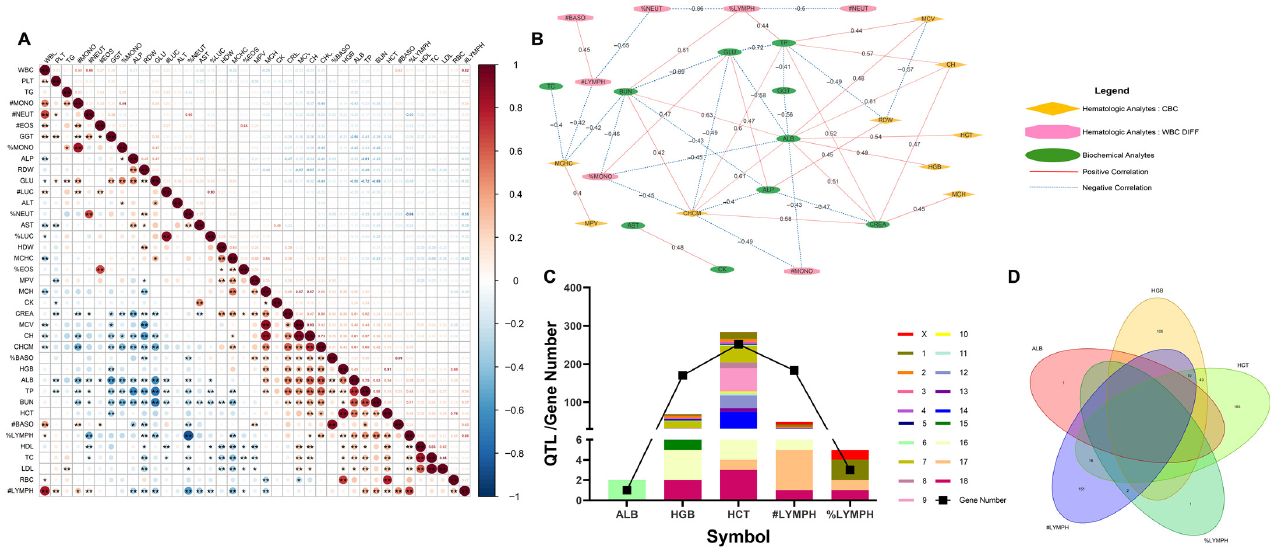
Figure 1. Correlation and bioinformatic analysis of blood parameters. ( A ) Heatmap showing corre- lation between different blood parameters. Pearson’s correlation coefficients are shown on the top- right triangle, p -values (* p < 0.05, ** p < 0.01) are shown on the bottom left triangle. ( B ) Network analysis of correlation between different blood parameters. Percentage and absolute values of the same blood parameter were not included in the interaction analysis. p -value < 0.05 and |r| ≥ 0.4 were considered as the threshold values. ( C ) Quantitative trait locus and gene locations of ALB, HGB, HCT, #LYMPH, and %LYMPH. ( D ) Venn diagram of candidate genes in QTL regions of ALB, HGB, HCT, #LYMPH, and %LYMPH. WBC = white blood cell, RBC = red blood cell, HGB = hemo- globin, HCT = hematocrit, MCV = mean corpuscular volume, MCH = mean corpuscular hemoglobin, MCHC = mean corpuscular hemoglobin concentration, CHCM = cellular hemoglobin concentration mean, CH = corpuscular hemoglobin, RDW = red cell distribution width, HDW = hemoglobin dis- tribution width, PLT = platelets, MPV = mean platelet volume, NEUT = neutrophil, LYMPH = lym- phocyte, MONO = monocytes, EOS = eosinophil, BASO = basophilic granulocyte, LUC = unstained large cells, TP = total protein, ALB = albumin, AST = aspartate transaminase, ALT = alanine ami- notransferase, ALP = alkaline phosphatase, TC = total cholesterol, TG = triglyceride, GLU = glucose, CREA = creatinine, HDL = high-density lipoprotein, LDL = low-density lipoprotein, BUN = blood urea nitrogen, GGT = gamma-glutamyl transpeptidase, CK = creatine kinase, ‘#’ = absolute value, ‘%’ = percentage value. 3.2. Determination of Difference in Blood Parameters between Nursery Pigs and Sows To assess the influence of age on blood parameters in nursery pigs, we analyzed the significant differences in blood parameters between nursery pigs at different ages. There were no significant differences ( p > 0.05) in six hematologic parameters among nursery pigs at different ages (Supplementary Table S3). Among the other 19 hematologic param- eters, only RDW showed significant differences ( p < 0.05) between all nursery pigs at dif- ferent ages. Furthermore, although age had a significant effect in nursery pigs, only TP and ALB were significantly different between all ages (Supplementary Table S4). We then determined the significant differences in blood parameters between nursery pigs and sows. As expected, 19 out of the 25 hematologic parameters showed significant differences ( p < 0.05) between nursery pigs and sows (Table 1). Moreover, 12 out of the 14 biochemical parameters were significantly different between nursery pigs and sows (Ta- ble 2). Thus, it is necessary to establish RIs of blood parameters for nursery pigs and sows separately.